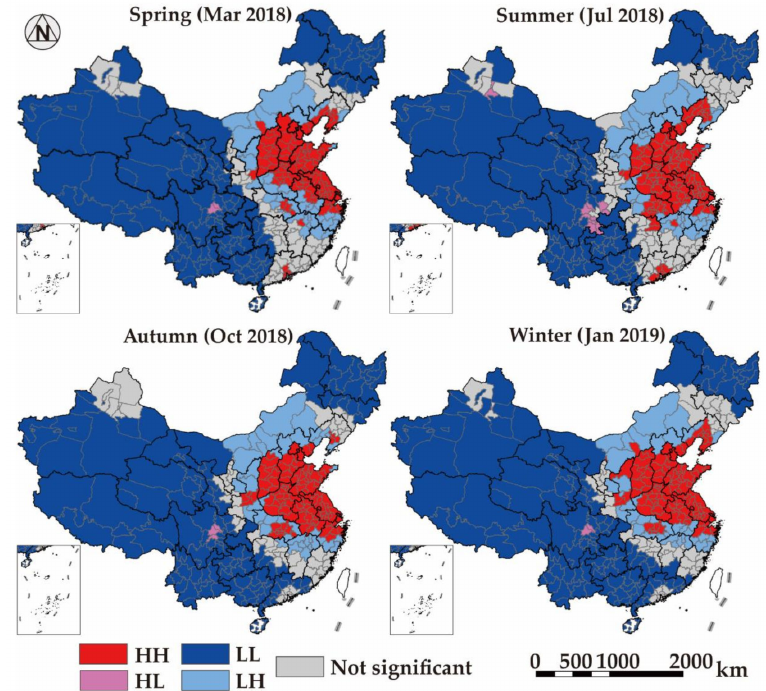
Figure 7. The Local Moran’s I result of prefectural unit in one month per